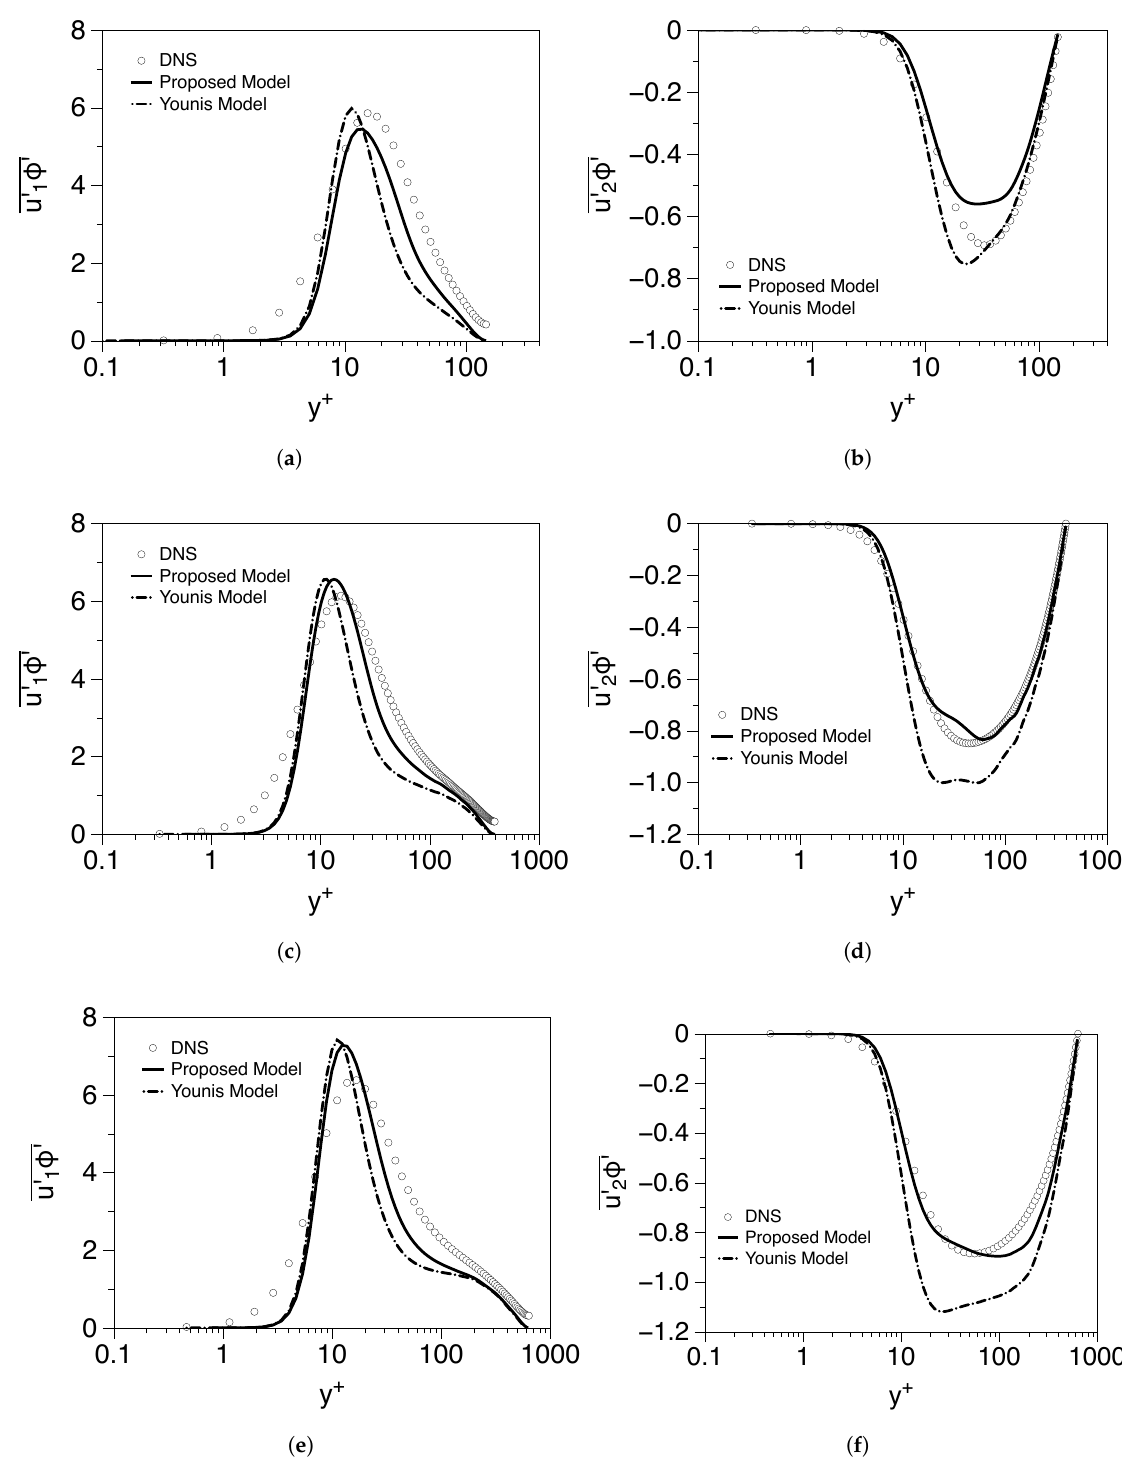
Figure 3. Model predictions for the scalar-flux components for a channel flow at Re τ = 150 ( a , b ), Re τ = 395 ( c , d ), and Re τ = 640 ( e , f